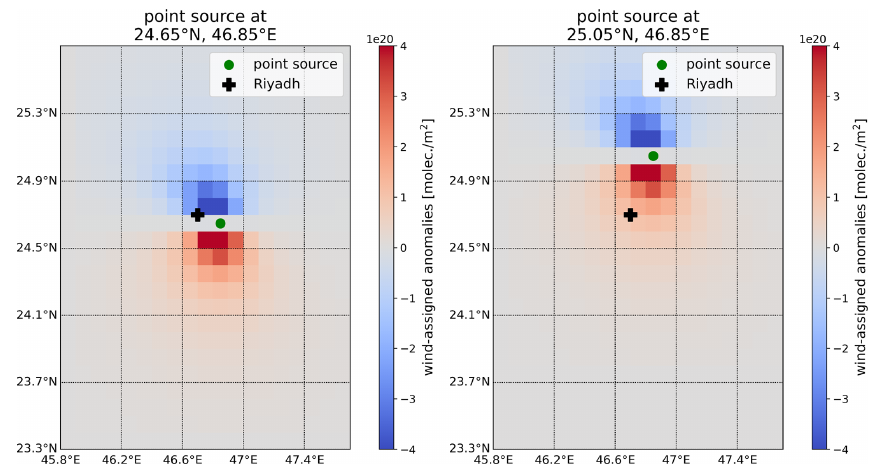
Figure A3. Examples of a wind-assigned plume for the point sources at 24.65 ◦ N, 46.85 ◦ E and at 25.05 ◦ N, 46.85 ◦ E in Riyadh.